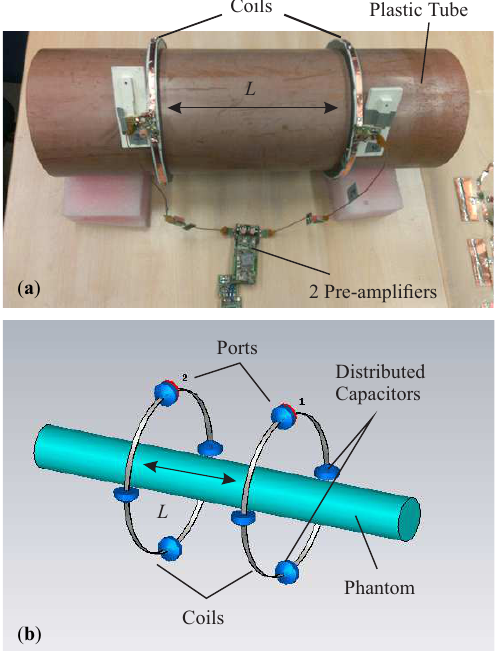
Figure 6. Two-channel coil arrangement for variation of coupling: ( a ) photograph; ( b ) model of electromagnetic field simulation. The two coils are positioned on a plastic tube and can be slid to change the distance L and therefore the coupling. The coil ports are connected to a pre-amplifier-board including a noise-matching network. In each coil four distributed capacitors are used for frequency tuning, one of which is parallel to the coil port. A saline water phantom is placed in the center of the